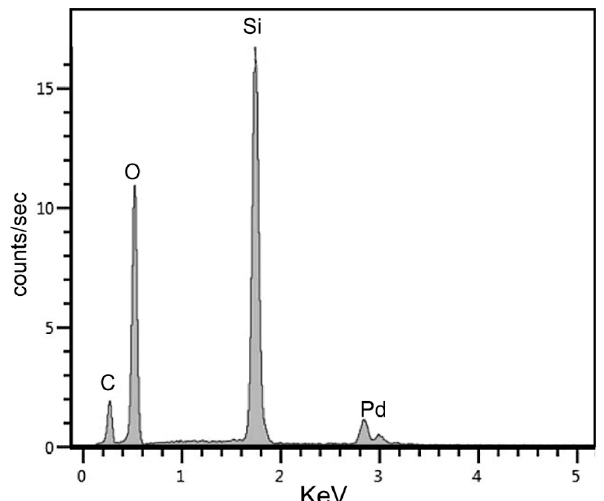
Figure 20. SEM / EDS spectra typically show silicon and oxygen as the major constituents, with a small peak representing relict carbon. The Pd peak is a spectral artifact caused by sputter-coating specimens with this metal to provide electrical conductivity.